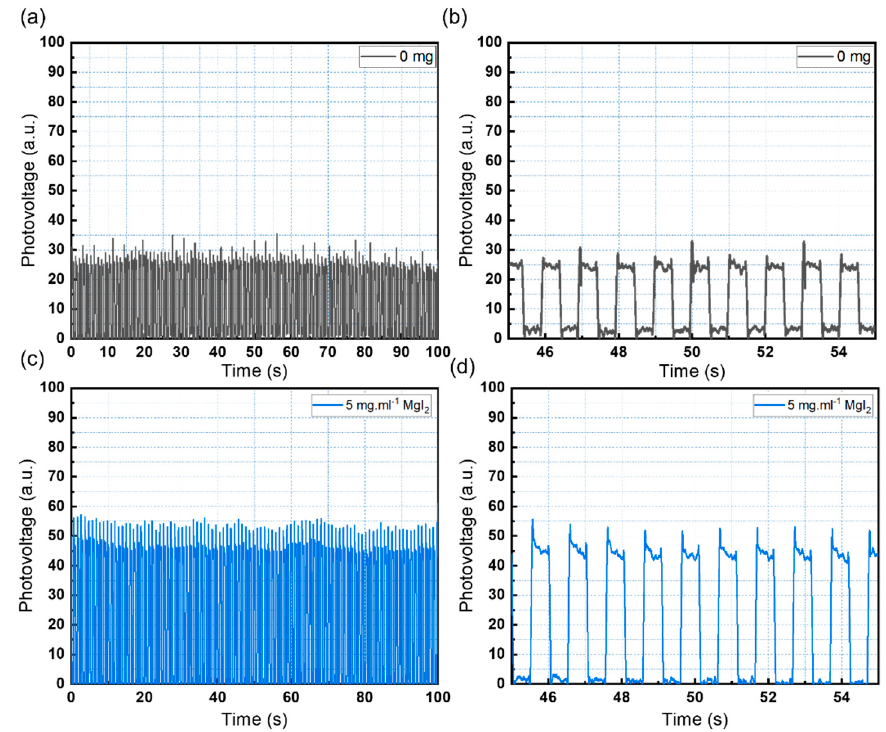
Figure 5. ( a ) On-off cycles of the pristine CsPbBr 3 photodetector. ( b ) Enlarged detail of the pristine sensor response. ( c ) On-off cycles of the CsPbBr 3 photodetector with 5 mg·mL − 1 of MgI 2 . ( d ) Enlarged detail of the modified sensor response.